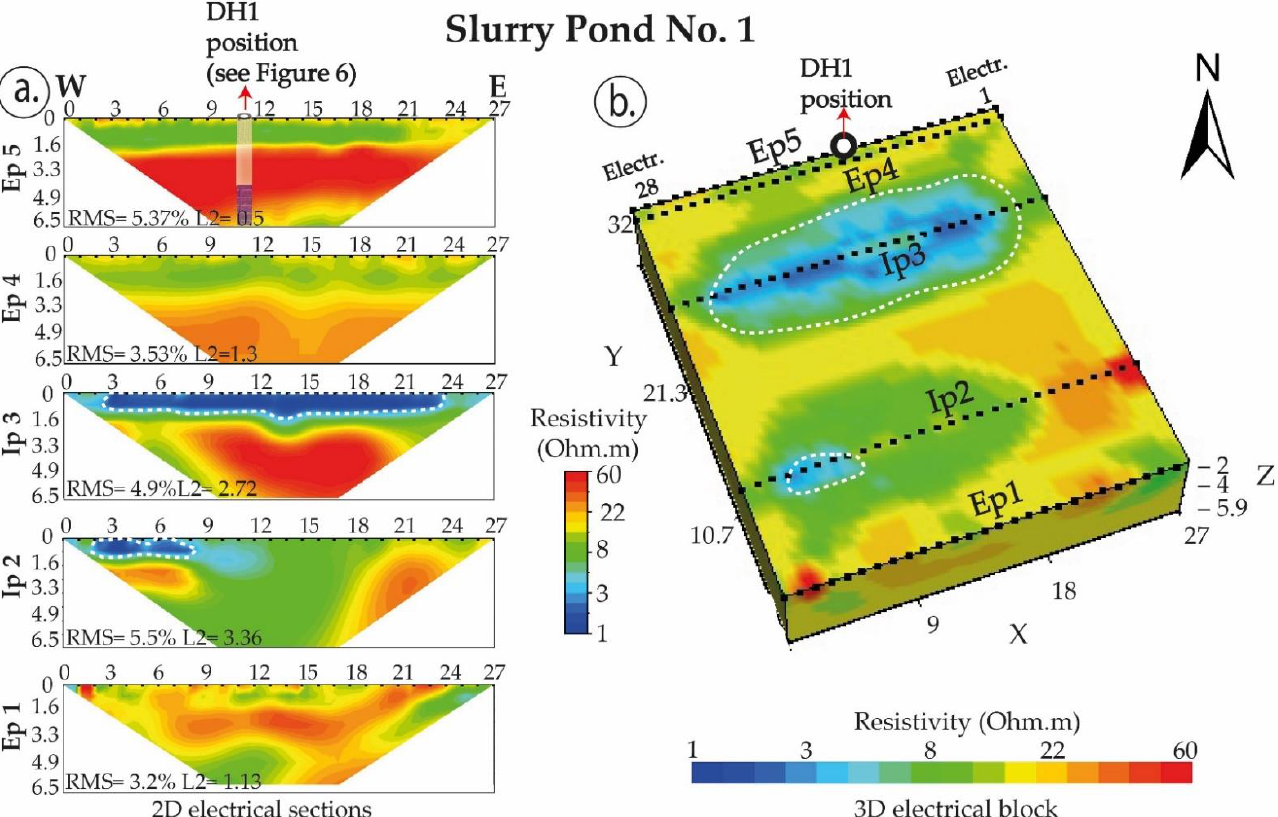
Figure 7. Slurry pond No. 1. ( a ) ERT 2D electrical sections and ( b ) ERT 3D electrical block. RMS and L2 stand for root-mean squared error and L2 norm, respectively. Electrode spacing is 1 m.